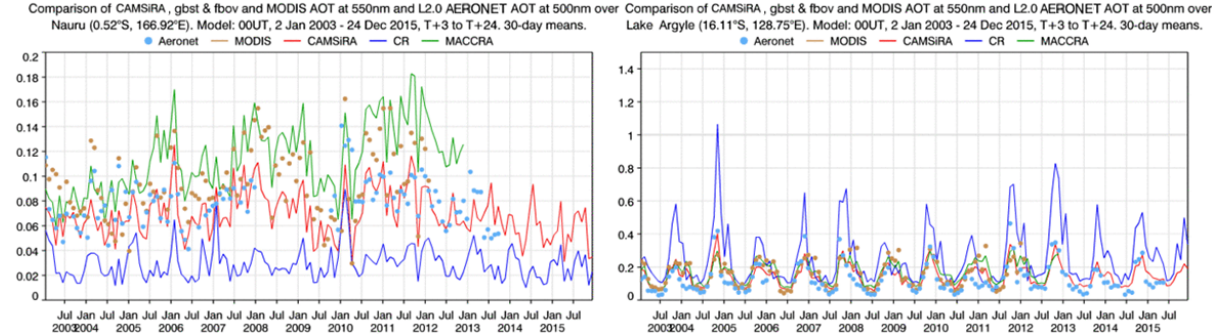
Figure 12. Time series of monthly mean AOD from AERONET observations (light blue dots), MODIS retrievals (brown dots) and from CAMSiRA (red), the CR (blue) and MACCRA (green) at Nauru (left) and Lake Argyle